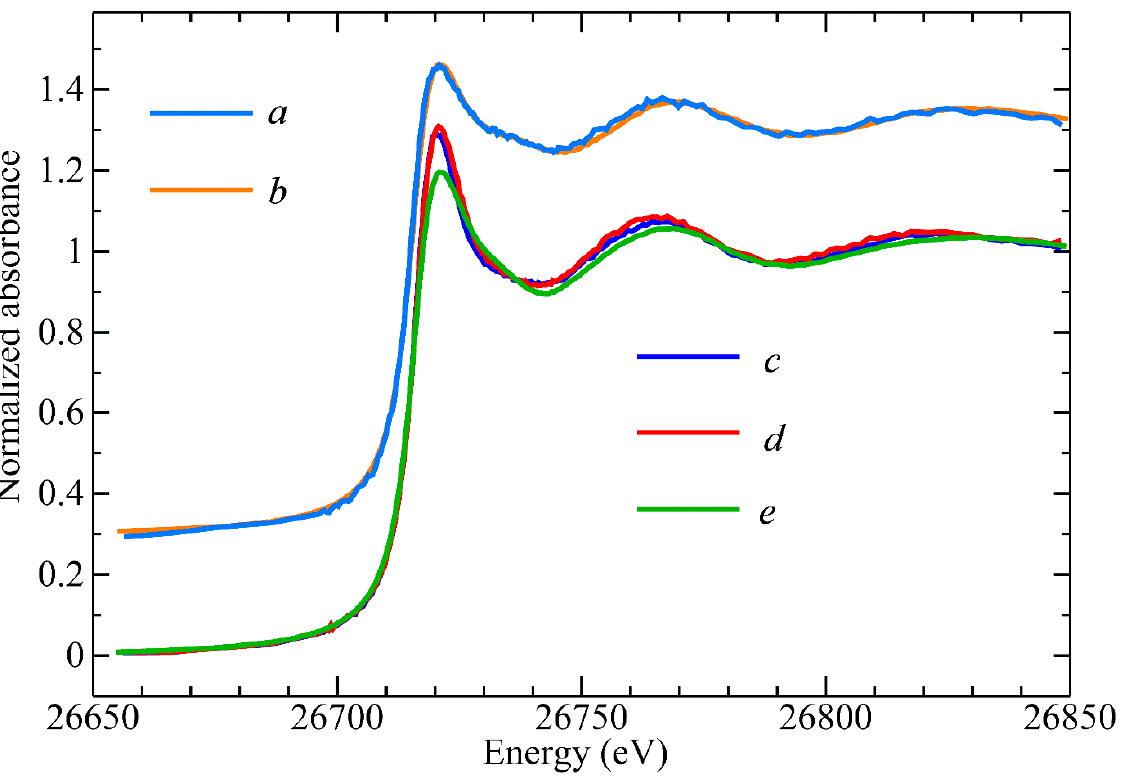
Figure 2. Comparison of Cd K near-edge spectra. (top) Cd 2+ complex obtained with 200 µ M Cys ( a ) compared with 1:1 ratio of Cd 2+ with DMSA standard ( b ), (bottom) Cd complex obtained with 100 µ M Cys ( c ), and Cd complex obtained with Tris-buffer ( d ) compared with 1:0.5 ratio of Cd 2+ with DMPS standard ( e